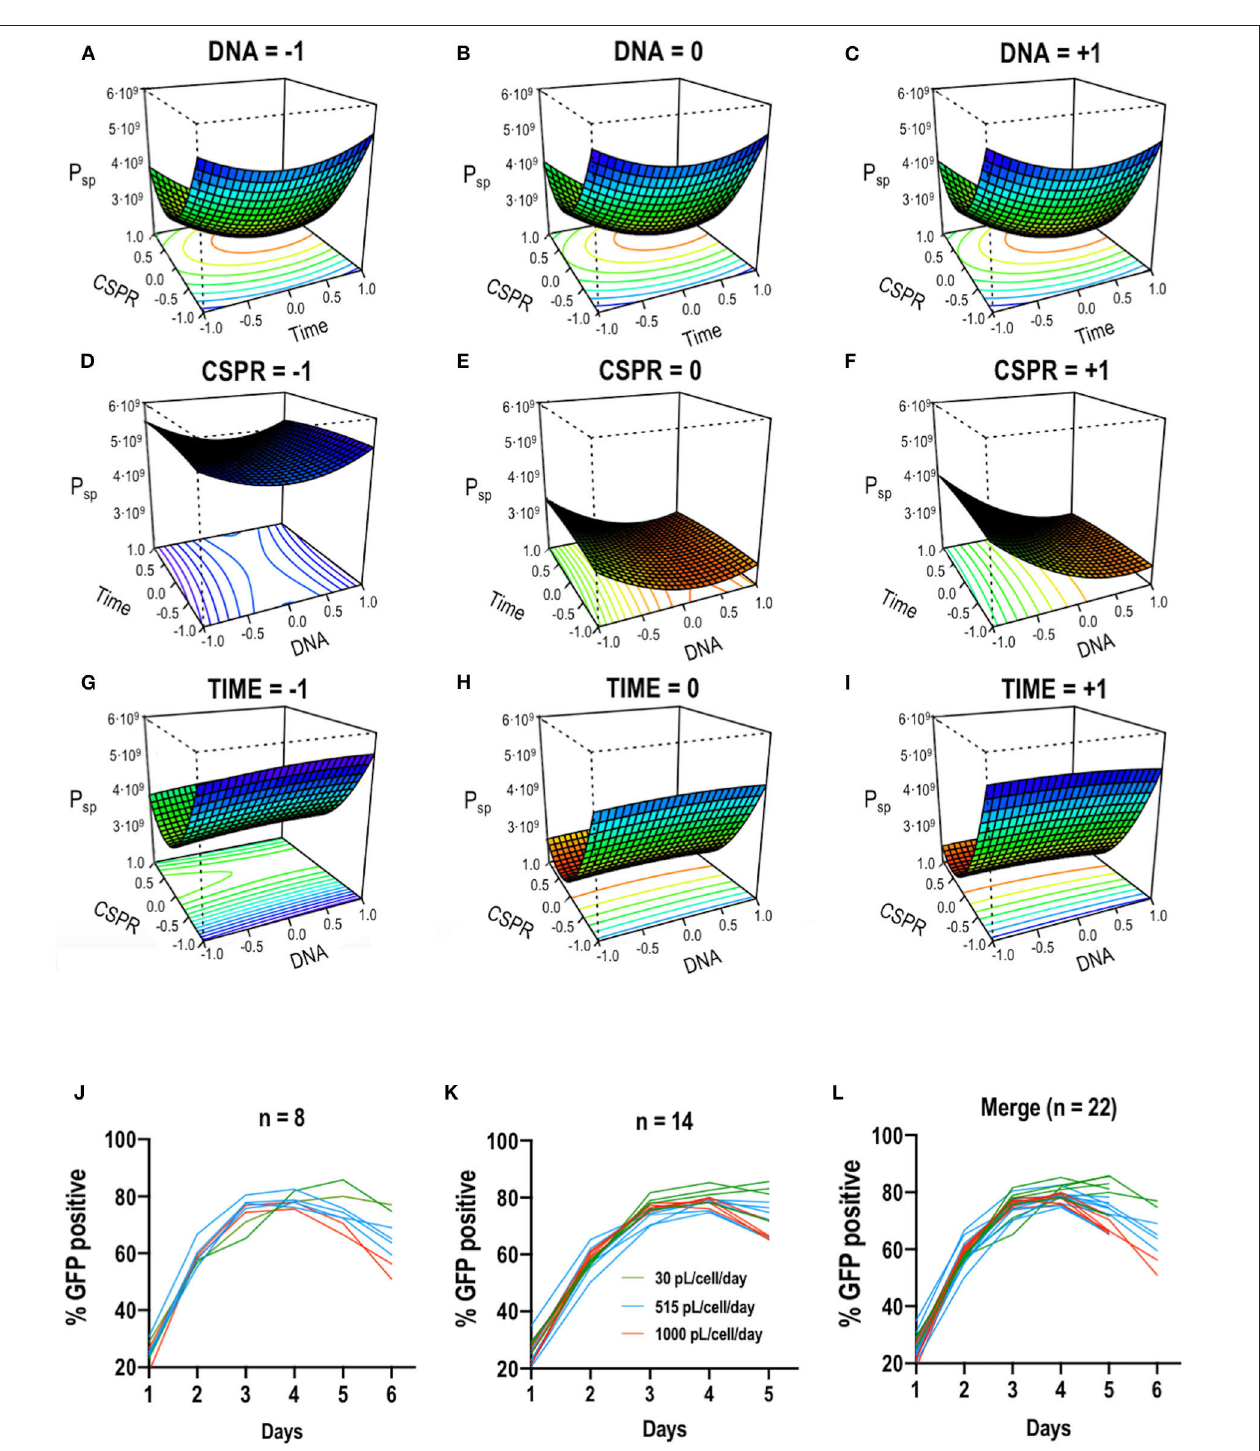
FIGURE 2 | Response surface graphs based on Box-Behnken experimental results. Maximum VLP specific production in cell culture supernatants as a function of (A–C) CSPR vs. Time; (D–F) time vs. DNA; and (G–I) CSPR vs. DNA. The graphs were constructed by depicting two variables at a time and maintaining the third one at a fixed level. + 1, 0, and − 1 correspond to 0.5, 1.25, and 2 mg/mL for the DNA concentration; 30, 515, and 1000 pL/cell/day for the CSPR and 24, 48, and 72 hpt for the time of retransfection. (J–L) represent the changes of the percentage of transfection measured in percentage of GFP positive cells along the studied time course for conditions reaching the sixth day of the process (J) and conditions reaching the fifth (K) . (L) Shows the merged plot.